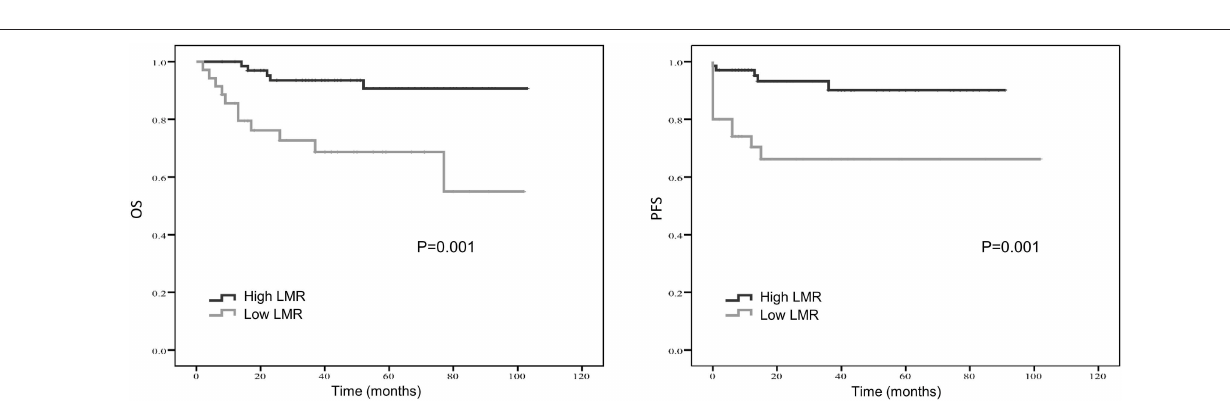
FIGURE 3 | Kaplan-Meier estimates of overall survival (OS) and progression-free survival (PFS) probability according to pre-treatment lymphocyte-to-monocyte-ratio (LMR)